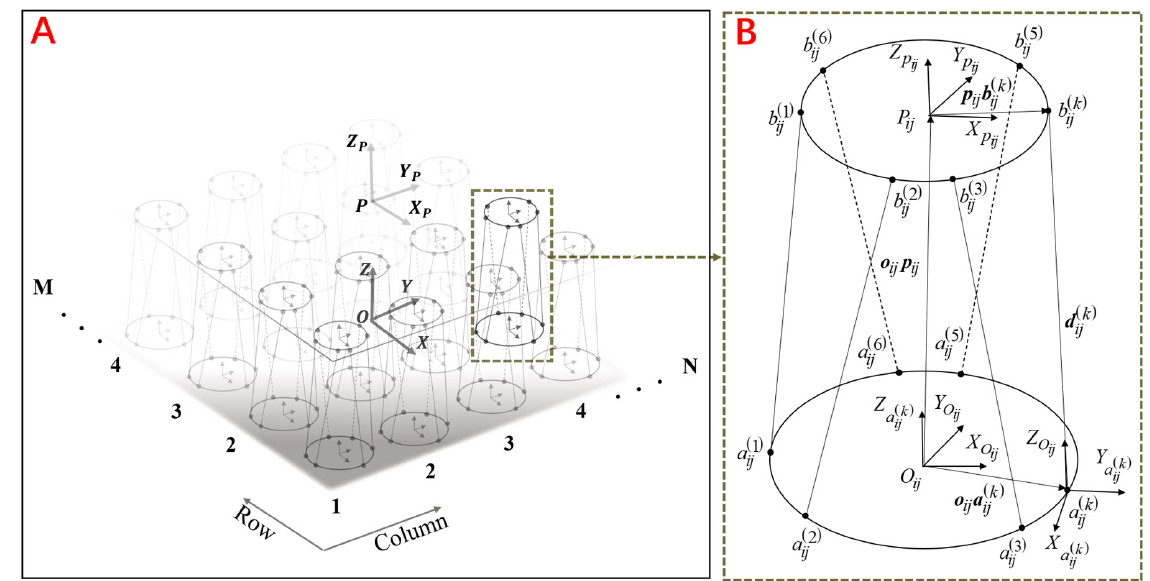
Figure 2. Kinematics model of ( A ) MCPM and ( B ) module